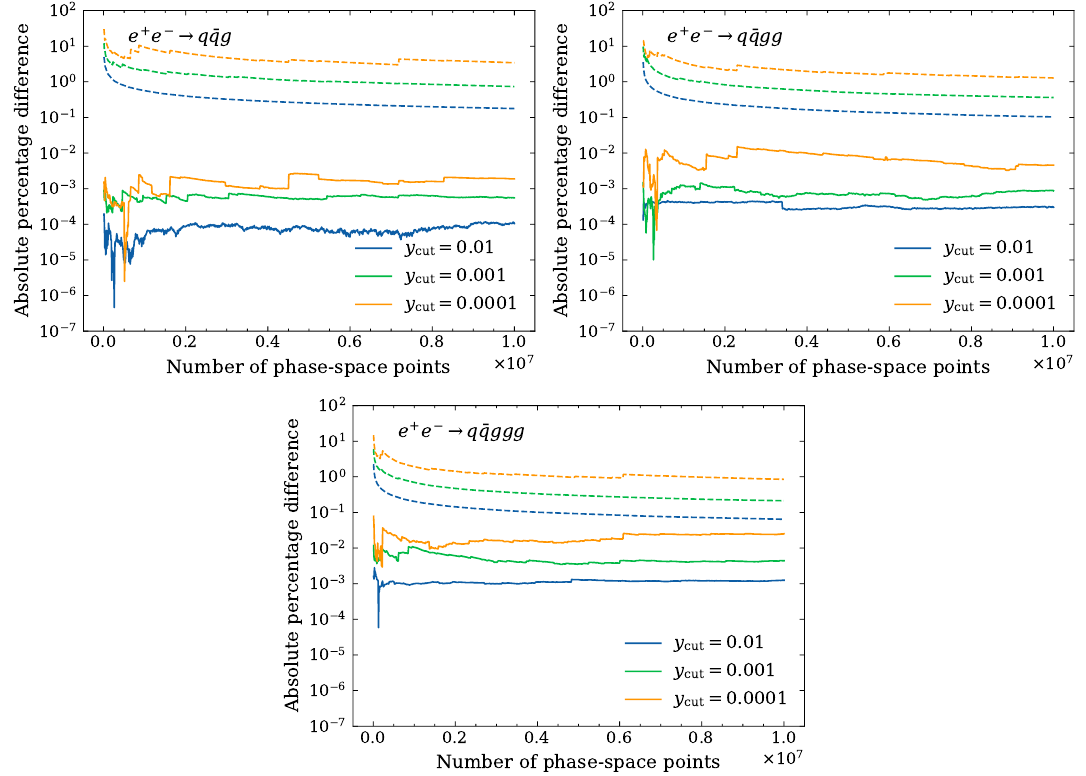
Figure 5 . Absolute percentage differences between NN and NJet cross-section predictions in solid lines. Dashed lines represent the Monte Carlo error expressed as a percentage error relative to the NJet cross-section calculated with the corresponding number of phase-space points. Cross-sections have been calculated at intervals of 100k points up to the full 10 million phase-space points in the test set. Axis scales have been fixed to highlight the differences between